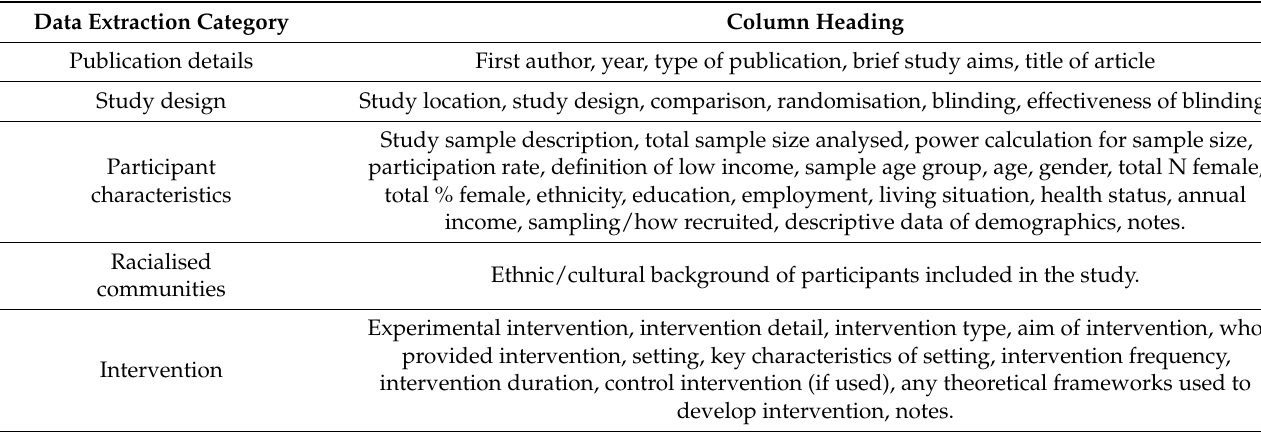
Figure 1. PRISMA Diagram. Table 3. Data extraction tool